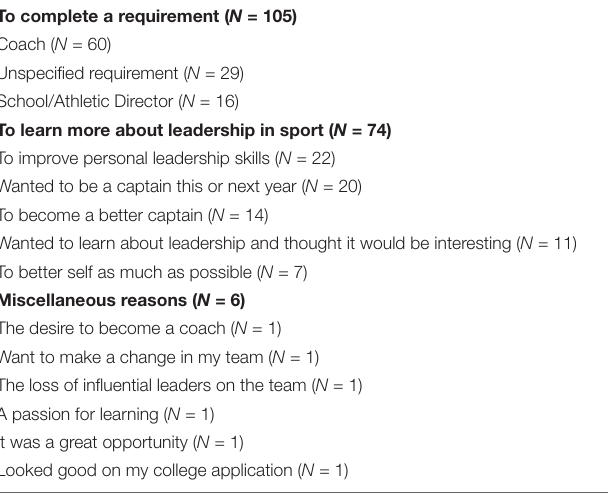
TABLE 2 | Motives for taking the NFHS leadership